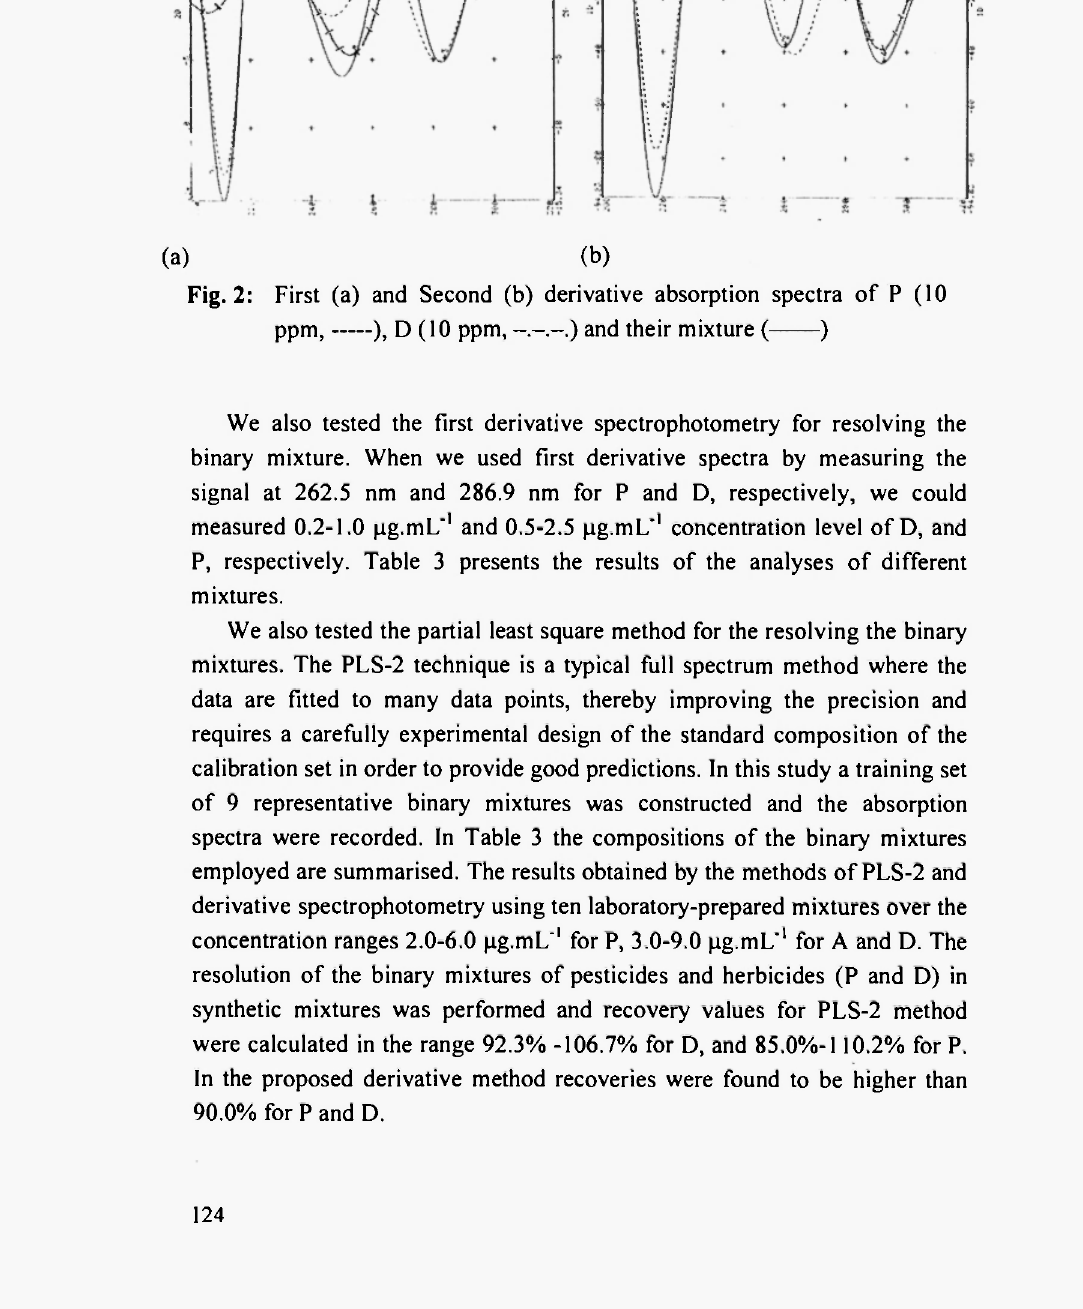
Fig. 2: First (a) and Second (b) derivative absorption spectra of Ρ (10 ppm, ), D (10 ppm, -.-.-.) and their mixture ( )